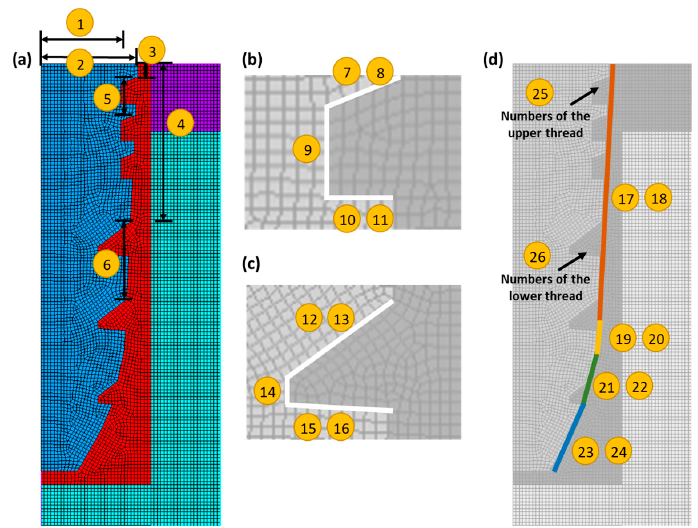
Figure A5. Illustration of the 26 parameters for implant geometry design, where ( a ) shows param- eters for implant width, upper part height, and lower part height; ( b ) shows those for details of the upper part; ( c ) shows those for details of the lower part; ( d ) shows those for details of the threads.